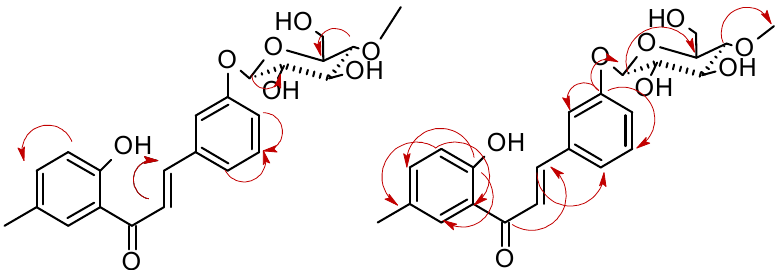
Scheme 3. Key Correlation Spectroscopy (COSY), (on the left) and HMBC (on the right) correlations for the structure elucidation of product 3a .